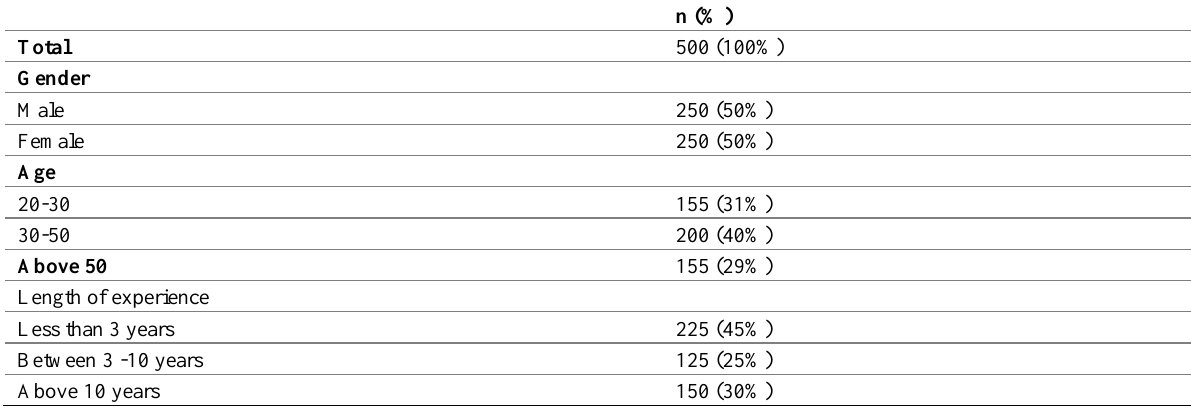
Table 1: Characteristics of the population.